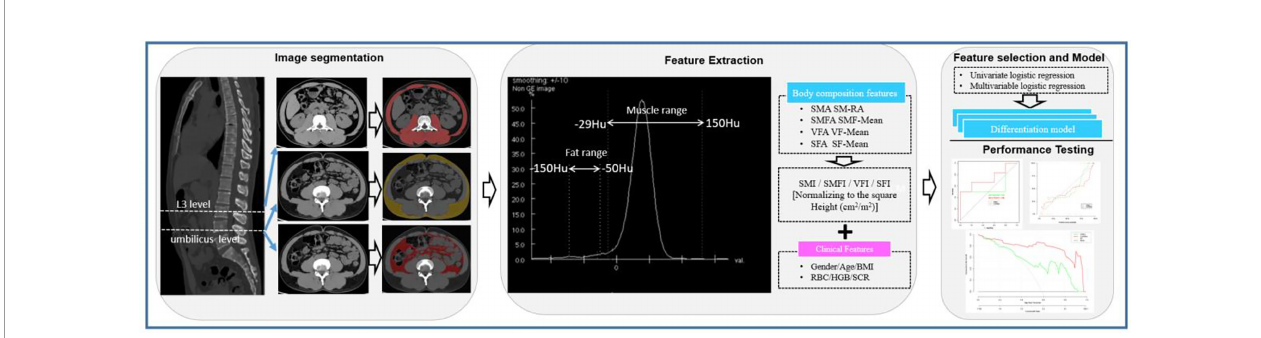
FIGURE 2 | Work fl ow for unenhanced abdominal CT images segmentation, feature extraction, selection, modeling, and performance testing for this study. (I) Segmentation of CT images. The third lumbar vertebra (L3) and umbilical level were selected for the body composition feature extractions. (II) Strategy for extracting body composition features from selected CT images. (III) Feature selection and prediction model construction with the univariate and multivariate logistic regressions based on the body composition and clinical features. Receiver operating characteristic (ROC) and calibration curves were applied to assess the model performance. Decision curve analysis was carried out to evaluate the clinical values of prediction models. L3 level, the third lumbar vertebra; SMA, skeletal muscle area; SM-RA, skeletal muscle radiation attenuation; SMFA, skeletal muscle fat area; SMF-Mean, skeletal muscle fat mean; VFA, visceral fat area; VF-Mean, visceral fat mean; SFA, subcutaneous fat area; SF-Mean, subcutaneous fat mean; SMI, skeletal muscle index; SMFI, skeletal muscle fat index; VFI, visceral fat index; SFI, subcutaneous fat index; RBC, red blood cell; HGB, hemoglobin; Scr, serum